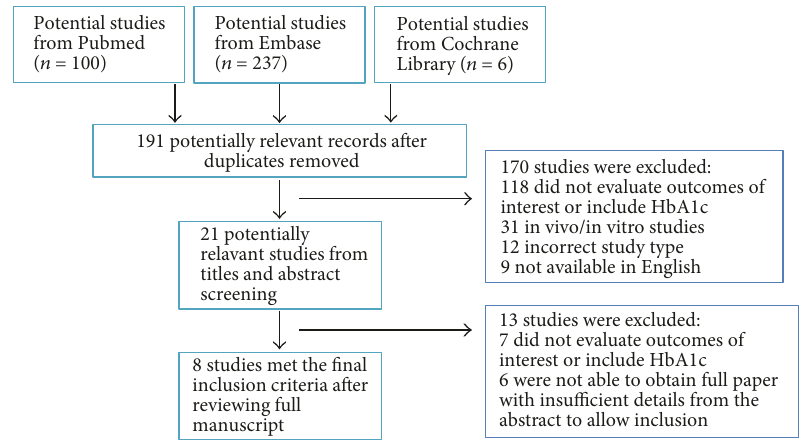
Figure 1: Study fl ow chart of study selection and